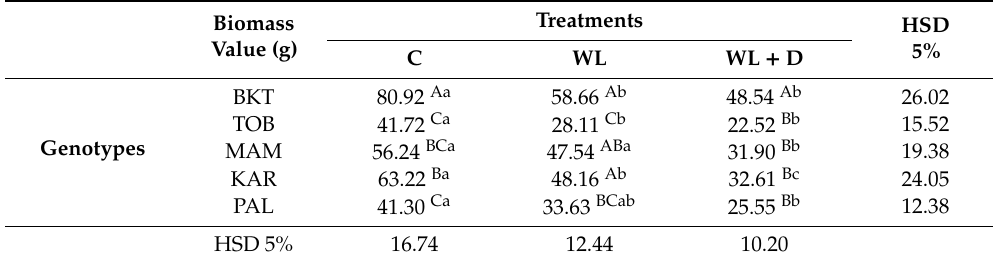
Table 1. Biomass values of ‘Bánkúti 1201’ (BKT), ‘Mv Toborzó’ (TOB), ‘Mv Mambó’ (MAM), ‘Mv Karizma’ (KAR) and ‘Mv Pálma’ (PAL) varieties in the different treatments. ‘C’: control treatment; ‘WL’: waterlogging treatment; ‘WL + D’: combined treatment of waterlogging and drought; HSD: